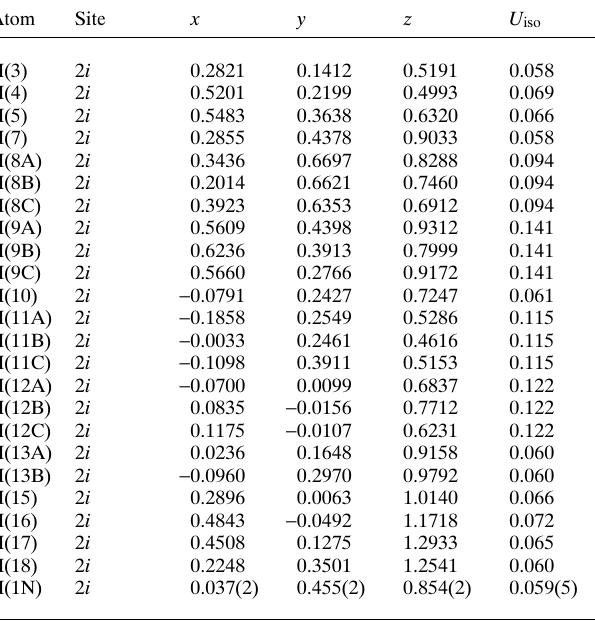
Table 2. Atomic coordinates and displacement parameters (in Å 2 )